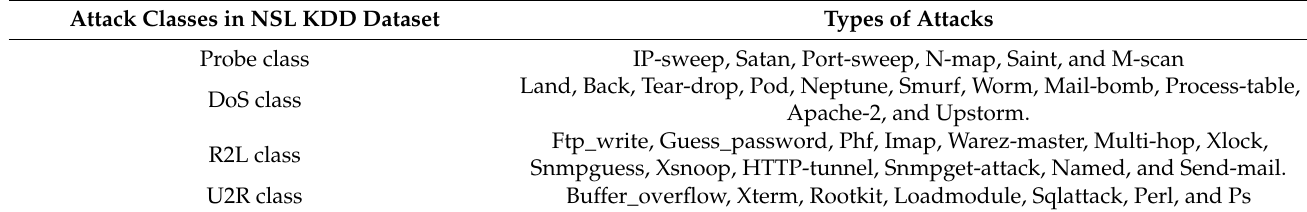
Table 5. Description of the NSL-KDD dataset.